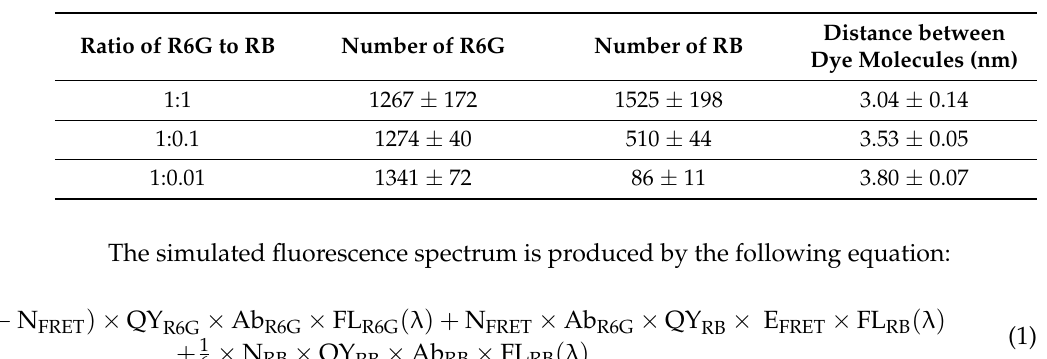
Distance between Dye Molecules